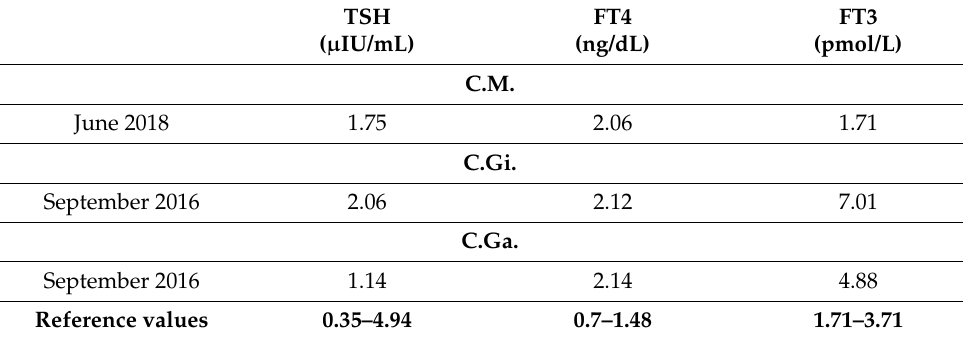
Figure 1. Mutation family tree. Patient 1 is indicated with a blue arrow, and shows the heterozygous THR β c.1378G>A p.(Glu460Lys) mutation. The same mutation was found in his father, brother, and son. Circles indicate females, squares indicate males. Table 2. Hormone serum levels of the relatives of the Patient 1.